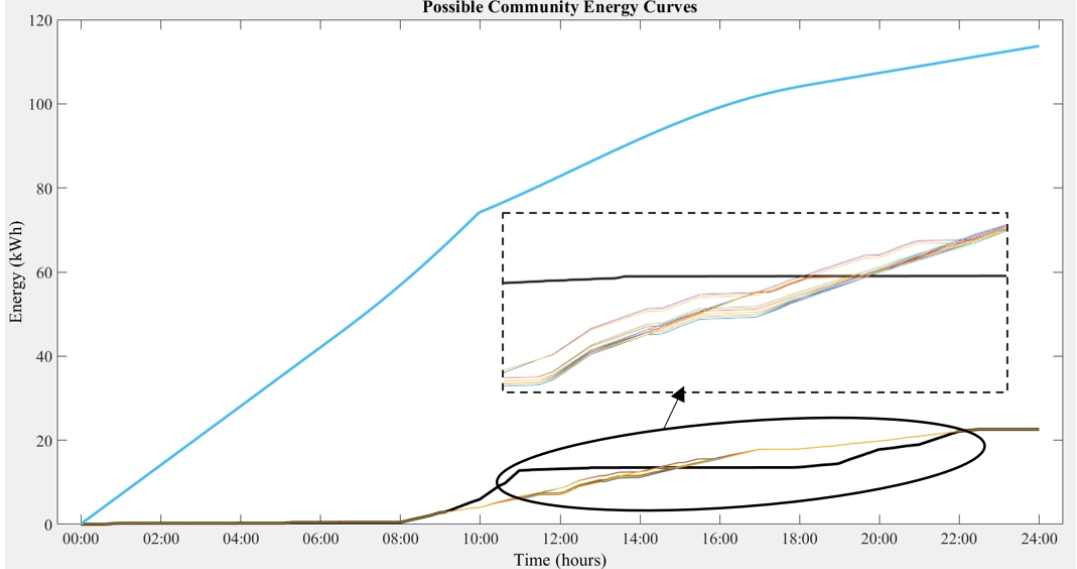
Figure 19. The community ’ s energy profile in scenario 3.